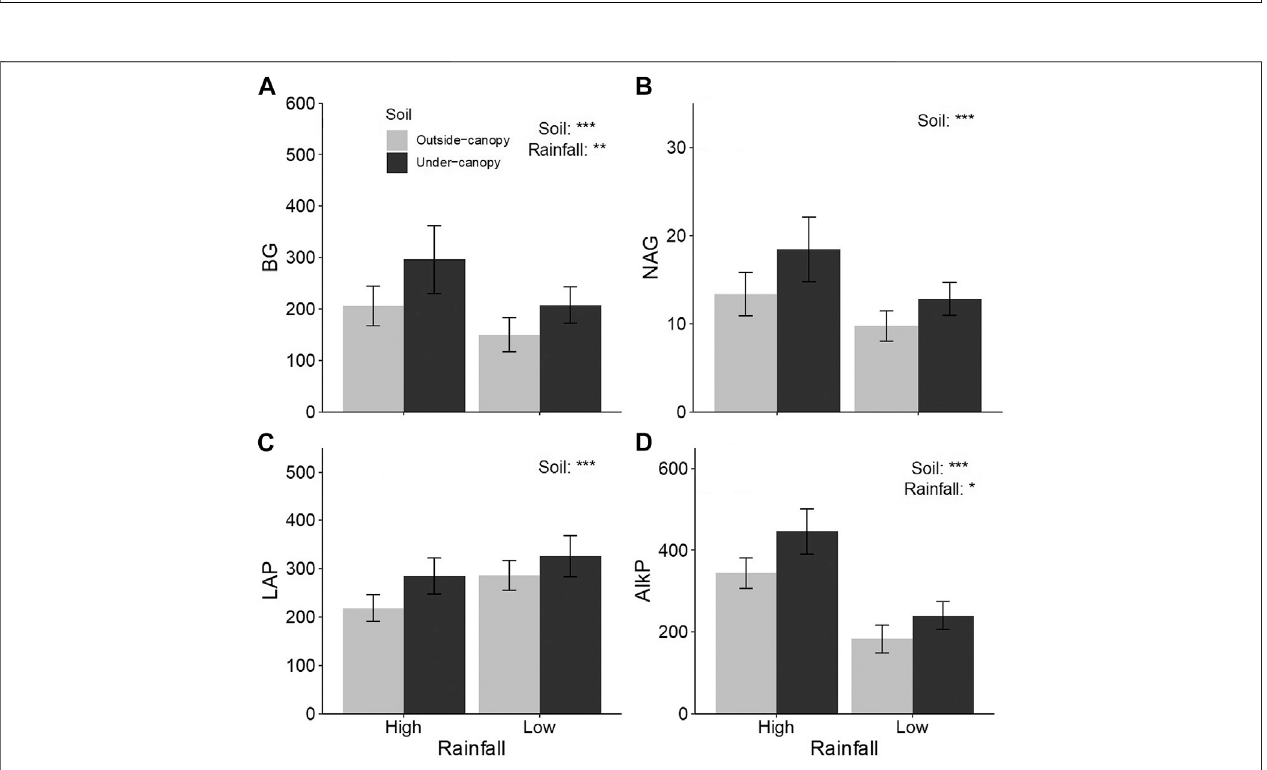
FIGURE2| Difference(mean ± CI)inpotentialactivitiesofextracellularenzymes (A) β -1,4-glucosidase(BG), (B) β -1,4-N-acetylglucosaminidase(NAG), (C) leucine aminopeptidase (LAP), and (D) alkaline phosphatase (AlkP) in soil under (Under-canopy, dark gray bars) and outside the canopy (Outside-canopy, light gray bars) of shrub species Artemisia gmelinii from sites of low and high rainfall. Statistical results are shown in Table 1 .